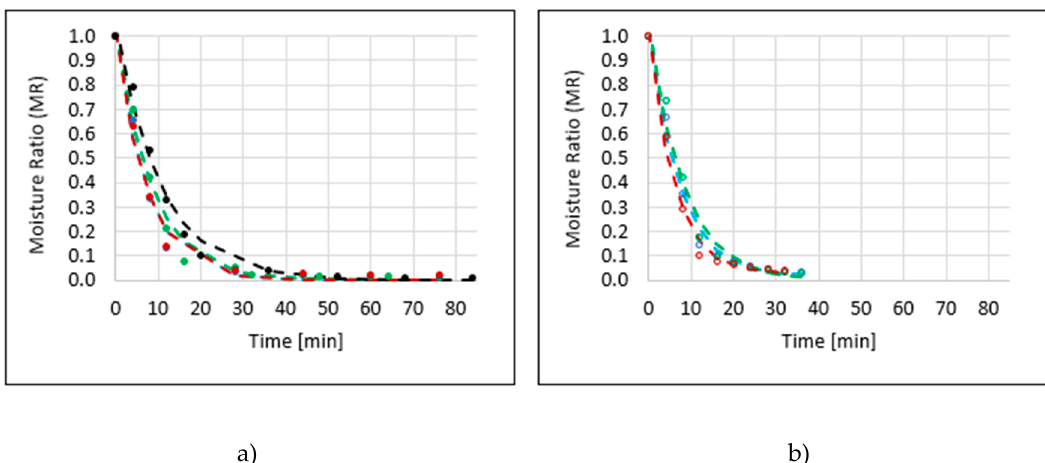
Figure 2. Drying kinetics of apple samples by the microwave-vacuum method (VM), previously osmo-dehydrated in erythritol (blue line), xylitol (green line), sucrose (red line), and without OD (black line), without application of ultrasound ( a ) or with US pre-treatment ( b ). Parameters of drying models and statistical values of RMSE and R 2 are presented in Table 1.